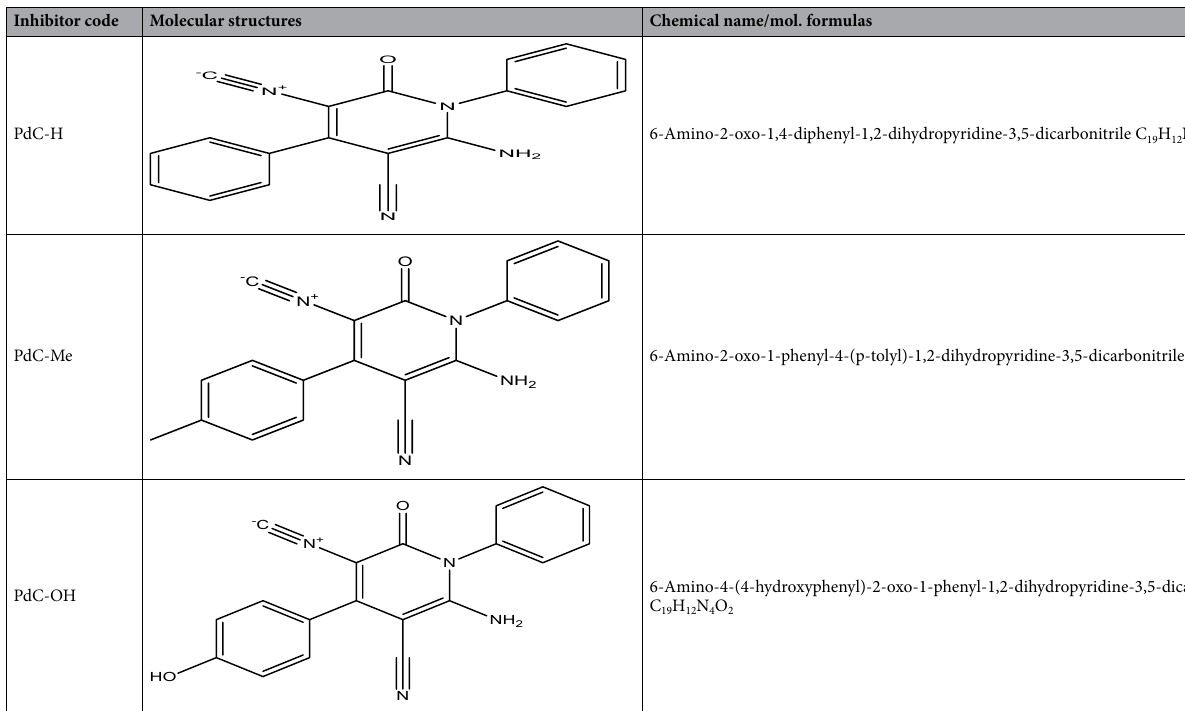
Table 2. Chemical structures of the tested compounds.